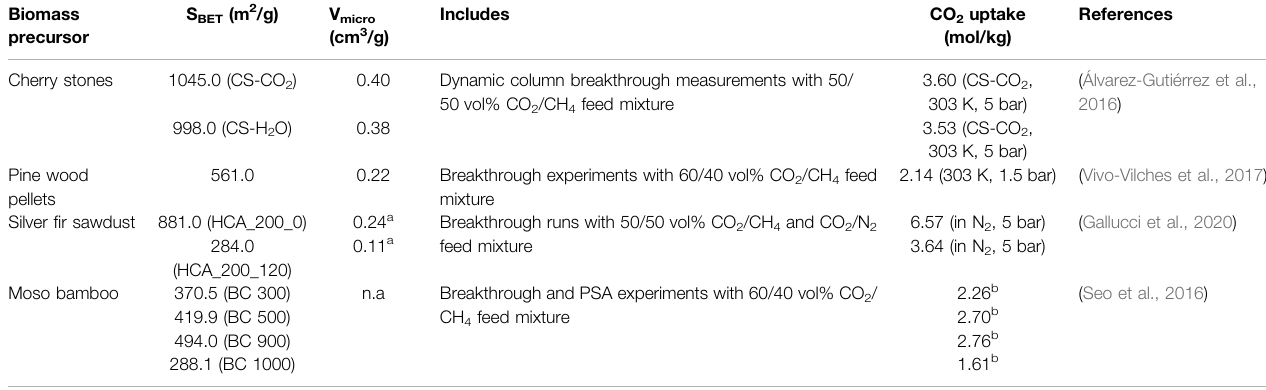
TABLE 2 | Last 5 years literature of biocarbons application in PSA technology for biogas upgrading. Biomass S BET (m 2 precursor